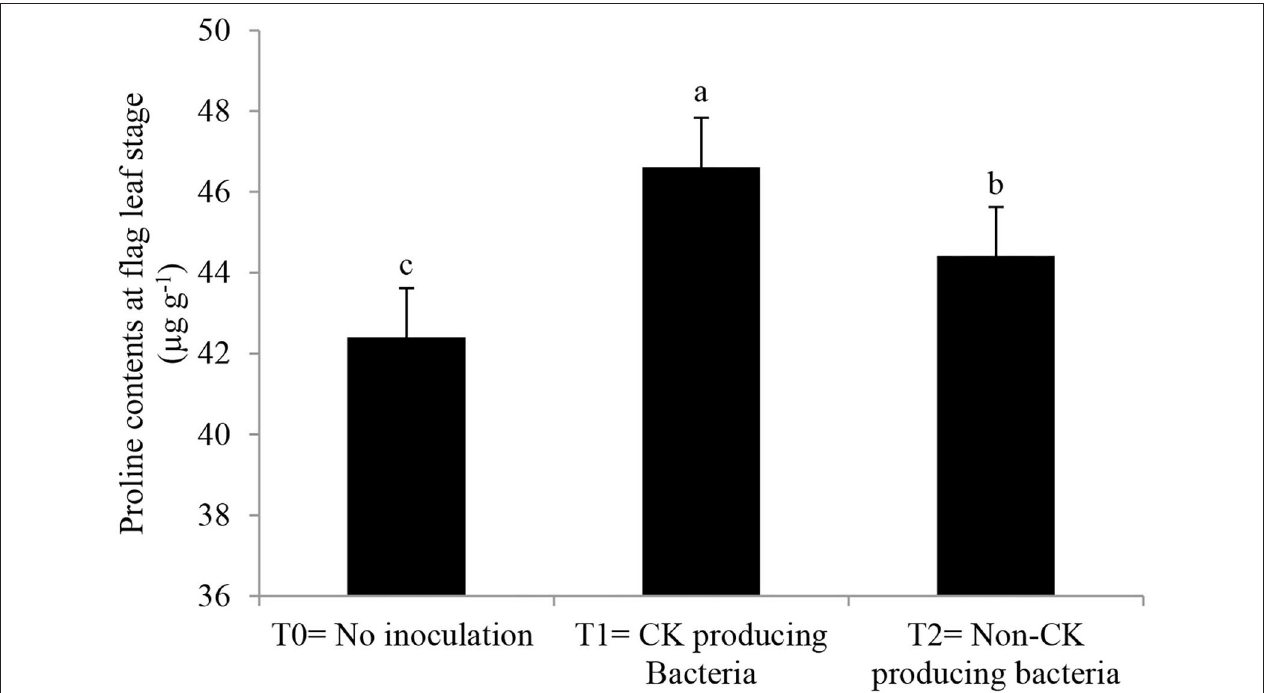
FIGURE 6 | Effect of Ck-producing A. brasilense RA − 17 and non-producing A. brasilense RA − 18 on proline content at flag leaf stage of wheat. The different letter shows a significant difference in treatments at a 5% probability